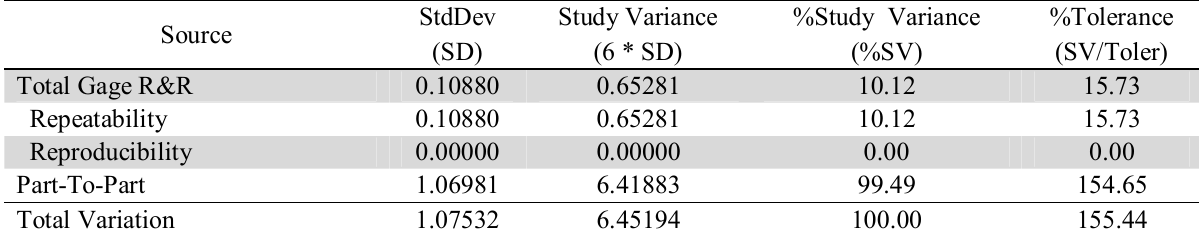
GageR&R results of MOR tested data